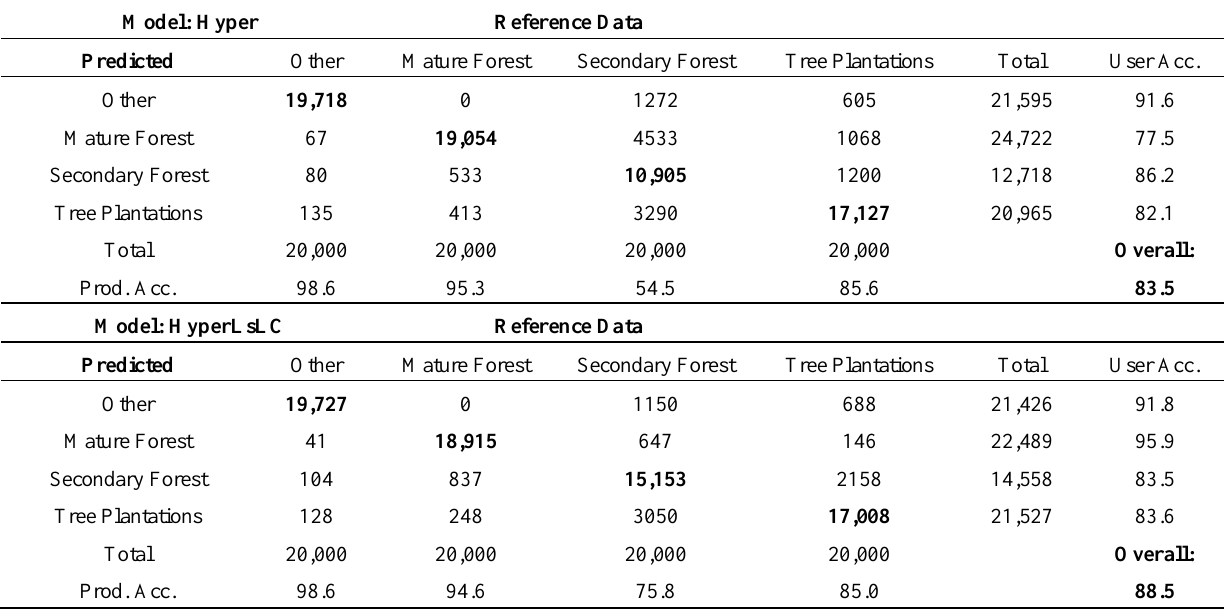
Figure 6. Producer’s and user’s accuracy for the Random Forest models, by summary land-use class (mean ± 95% CI). Producer’s accuracy is defined as 100 minus the error of omission for a given class, and user’s accuracy is defined as 100 minus the error of commission for a given class. Table 4. Confusion matrices of the bootstrap results for forest summary classes, comparing the Hyper RF model accuracy and the HyperLsLC RF model